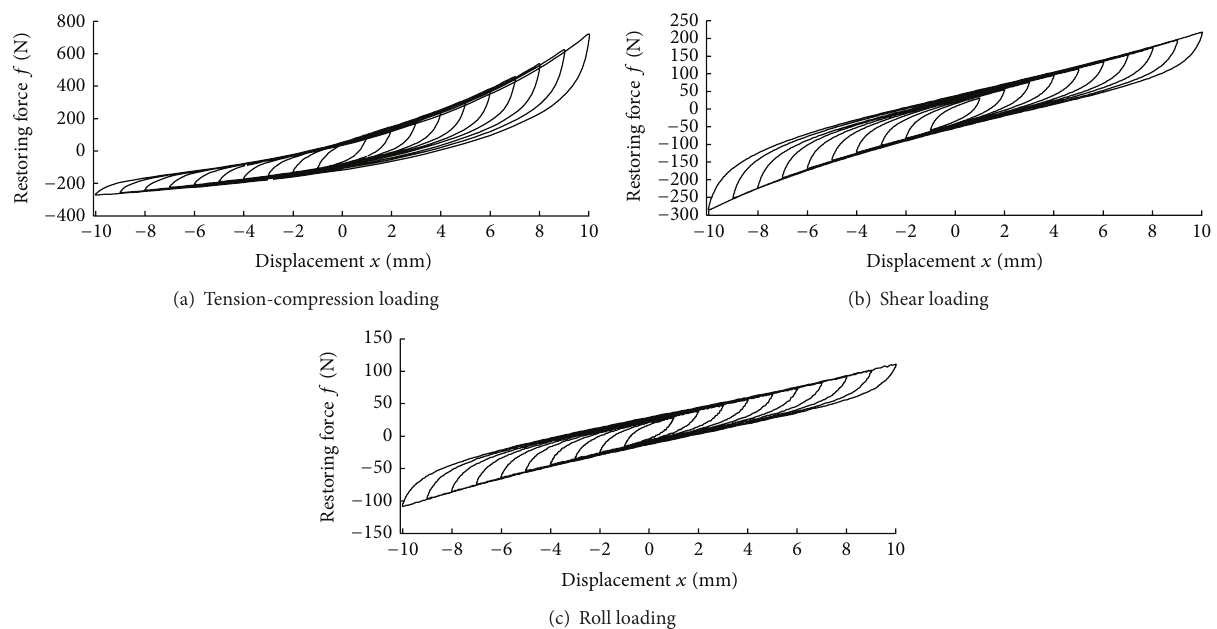
Figure 5: Experimental hysteresis loops with different displacement